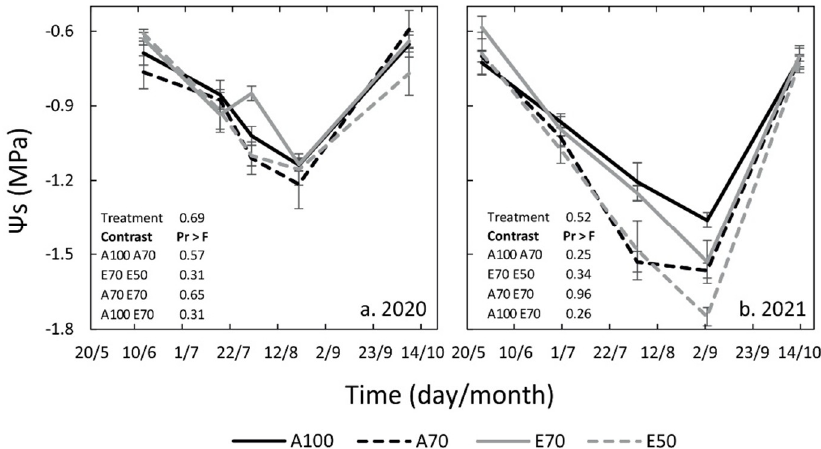
Figure 3. Seasonal patterns of PAR detected between 9:00 and 18:00 h of the outside reference and of the two net treatments, with average daily values. Different letters represent significant differ- ences at p < 0.05, from the end of May until mid-October, for 2020 ( a ) and 2021 seasons ( b ). Percent- ages reflect the level of shading in the various environments. Stars represent the dates of midday physiological measurements.